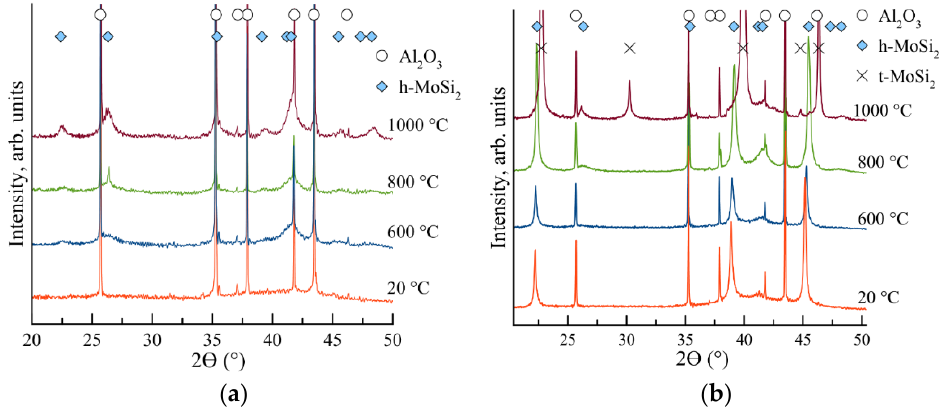
Figure 9. X ‐ ray diffraction patterns of the Mo ‐ Zr ‐ Si ‐ B coatings deposited by HIPIMS at 50 ( a ) and 200 Hz ( b ), in the as ‐ deposited state and after vacuum annealing at T = 600, 800, and 1000